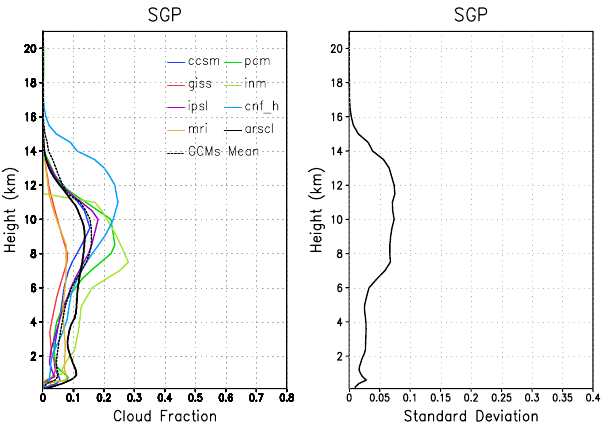
Fig. 11. Same as for Fig. 9, but for SGP.